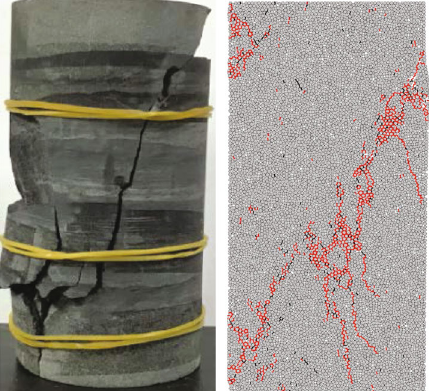
Figure 11: The failure